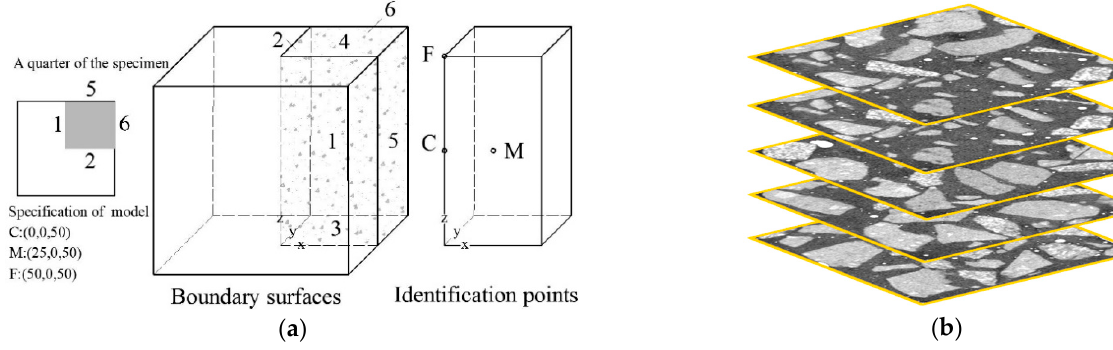
Figure 2. ( a ) The schematic diagram of specimen; ( b ) The two-dimensional scanning